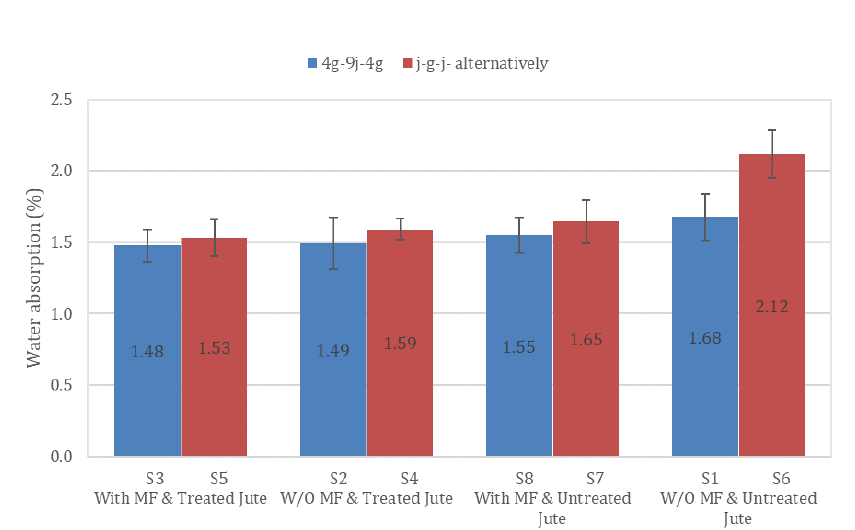
Figure 16: Effect of stacking sequence on water absorption of fabricated composite